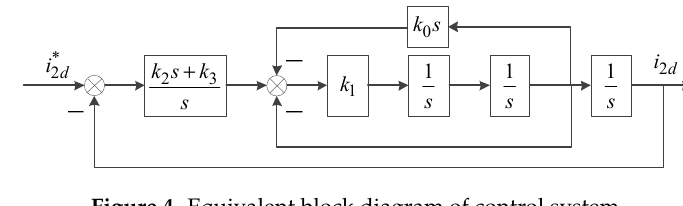
Figure 4. Equivalent block diagram of control system.